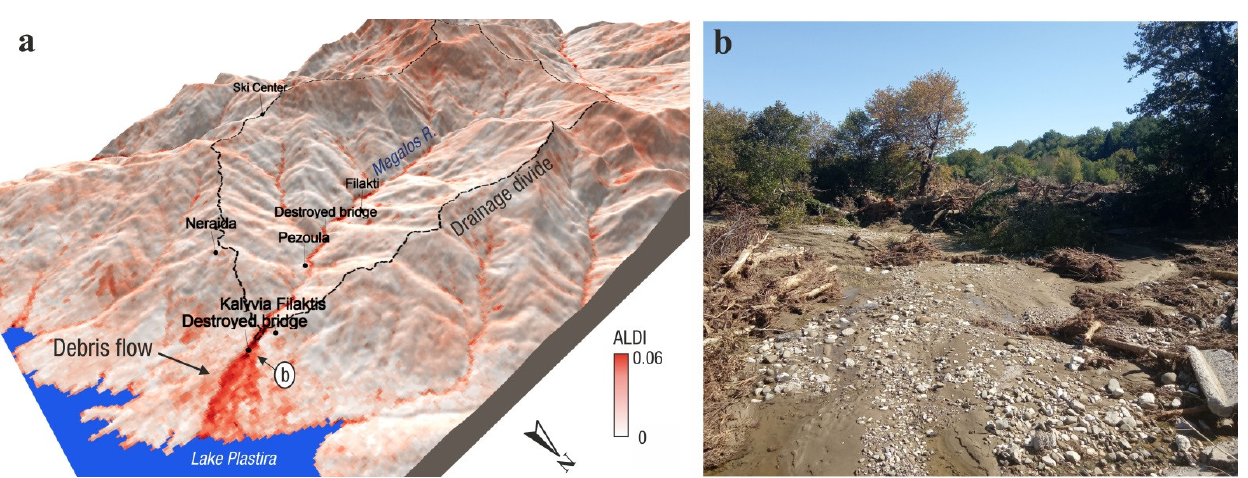
Figure 16. Debris flow and landslides along Megalos River in Filakti/Pezoula area ( a ). 3D view of the Megalos River watershed with debris flows along the main river course and its exit to Lake Plastira (red colors of ALDI change detection index values). Flooding, severe sedimentation and material transportation from upstream was mapped at its exit (photo ( b ), view towards east with location marked in ( a )) and near Pezoula. Road bridges were destroyed in both locations, with positions labeled in ( a ). Table 2. Positive and negative detection of mapped landslides by the different change detection methods.